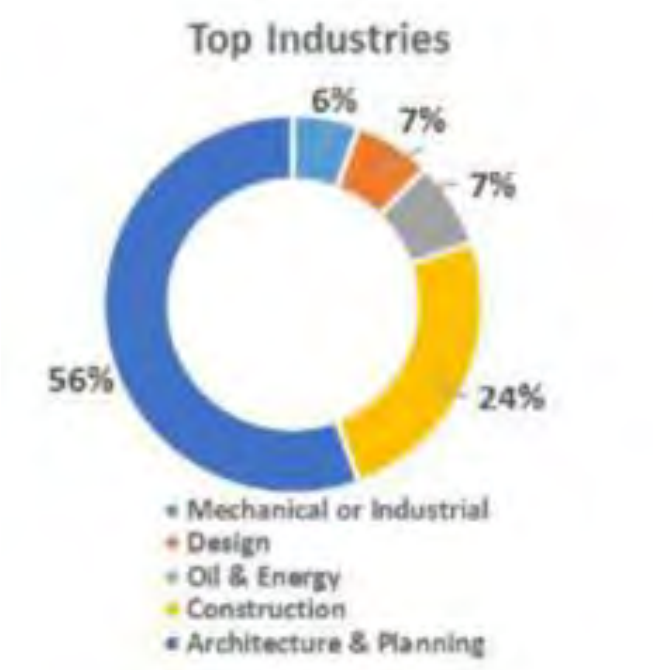
Figure 8. Insights about Architect - Top Gulf Consultant members on LinkedIn (”Architect — Gulf Consultant”, 2017). Required experience and skills vary based on the job responsibilities and description. Alison Doyle in her article about most wanted architectural skills argued that accreditation is more important to architects than being licensed. illustrates the most wanted skills as per statistics of Job Seeking site (Doyle,